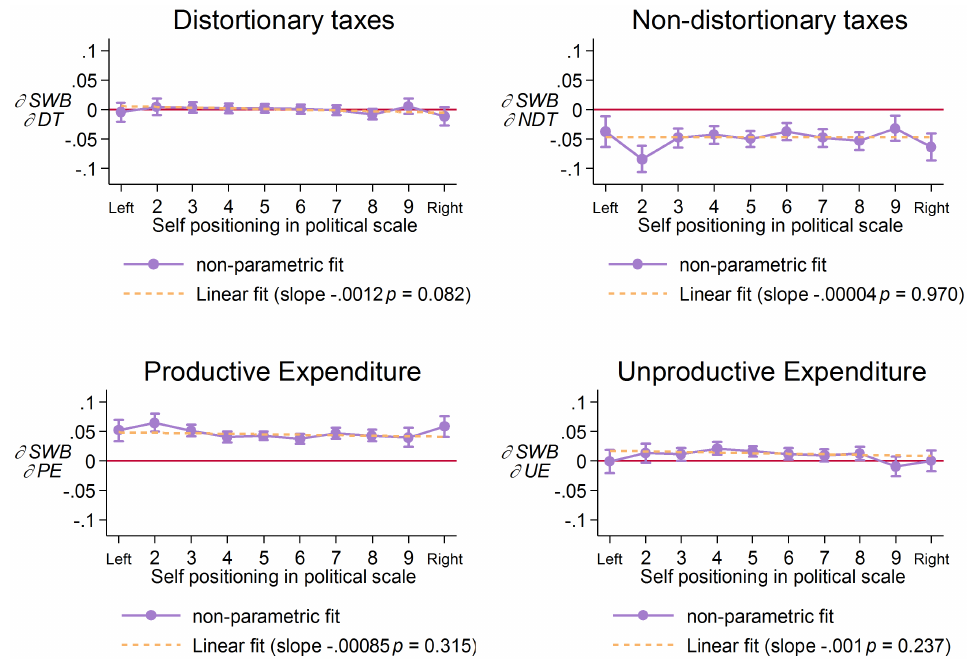
Figure 3: Marginal effects by self-expressed political orientation (90%